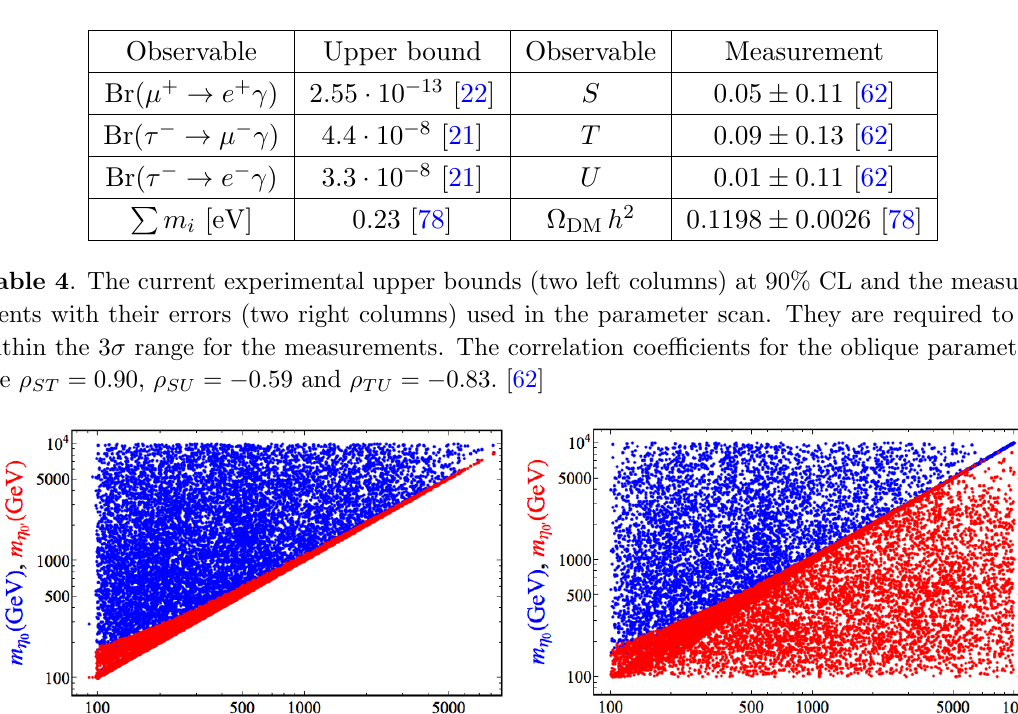
(cid:17) 0 0 and m (cid:17) 0 , in red and blue, respectively,